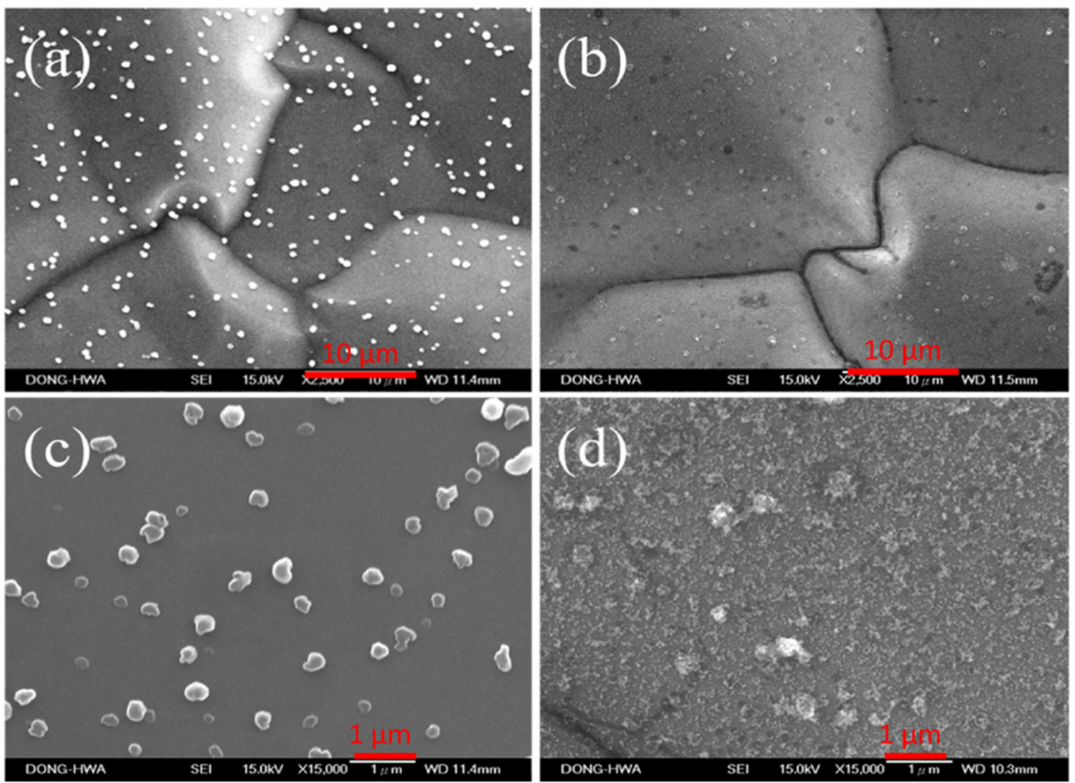
Figure 2. SEM images (2500 × ) of ( a ) non-modified and ( b ) APPJ-modified graphite sheets; SEM images in high magnification (15,000 × ) of ( c ) non-modified and ( d ) APPJ-modified graphite sheets.